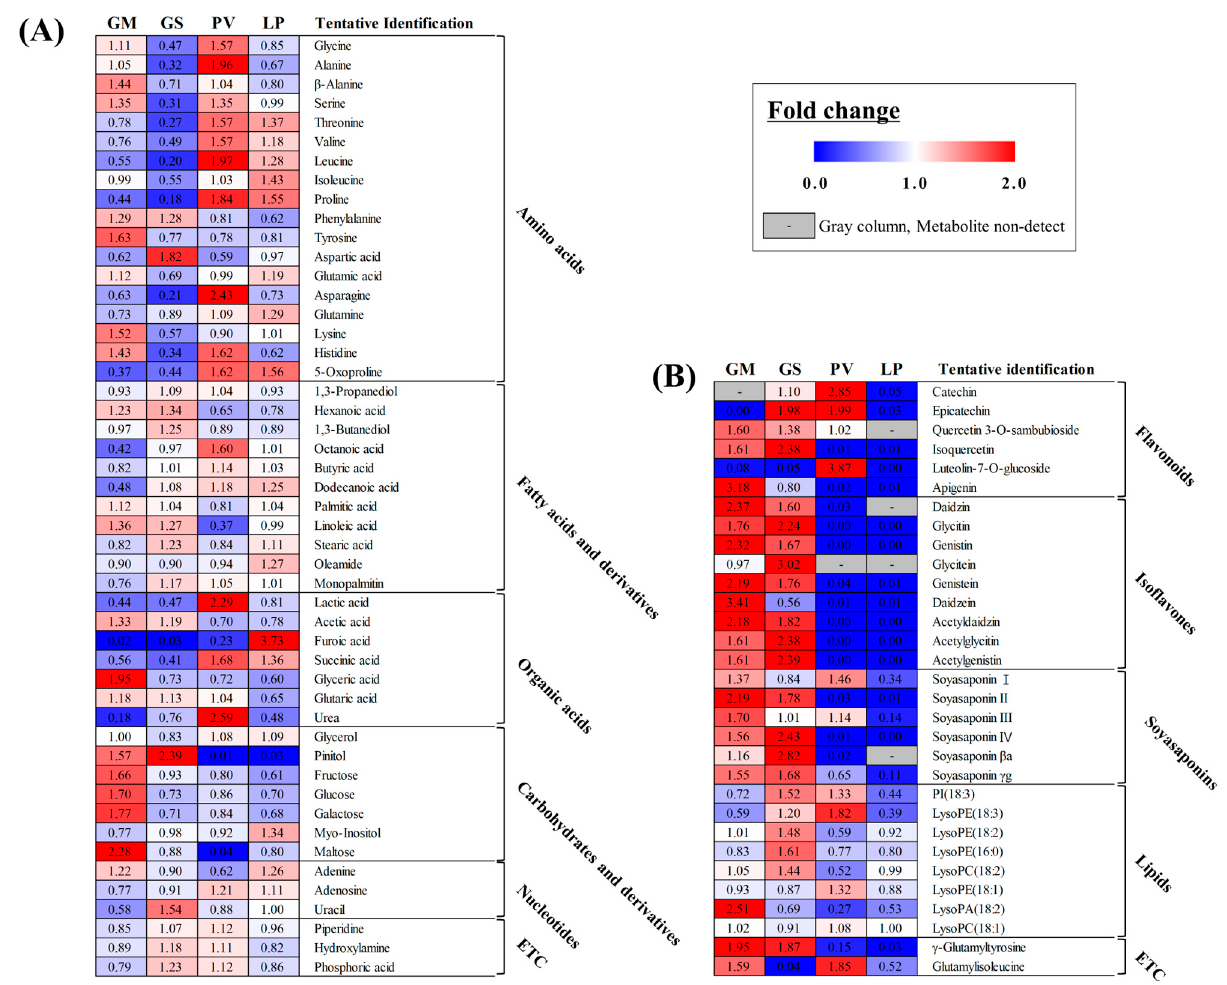
Figure 2 . Heatmap analysis of four beans based on GC-TOF-MS ( A ) and UHPLC-LTQ-Orbitrap- MS/MS ( B ) analyses. The heatmap represents the relative content of significantly different metabo- lites determined by the partial least squares discriminant analysis (PLS-DA) model (VIP > 0.7, p -value < 0.05). The colored blocks represent the fold changes (blue to red) normalized by the average of all values for each metabolite. The colors indicate the relative abundances of each metabolite. Blue color: lower content relative to the mean, red color: higher content relative to the mean. GM: G. max , GS: G. soja , PV: P. vulgaris , LP: L. purpureus